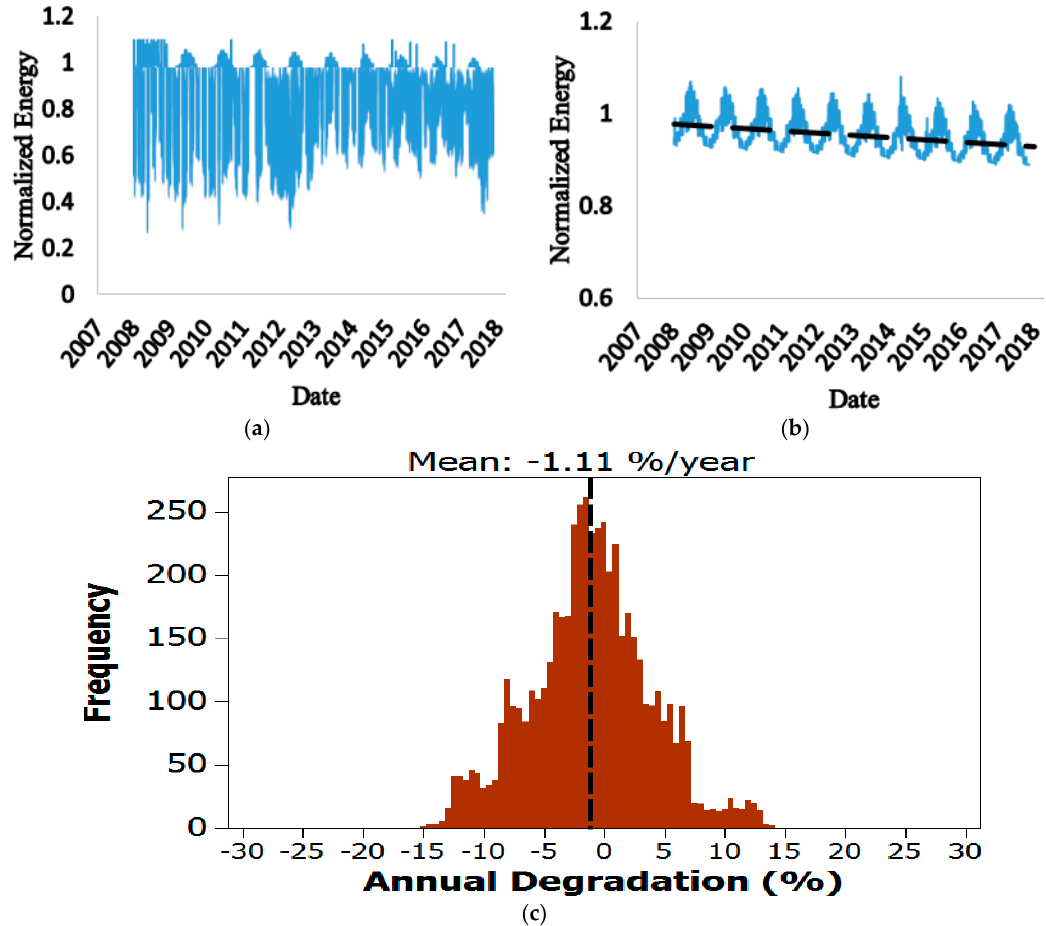
Figure 2. Example of the year-on-year (YOY) degradation process: ( a ) data filtration; ( b ) daily aggregation procedure; ( c ) the result of the degradation rate.